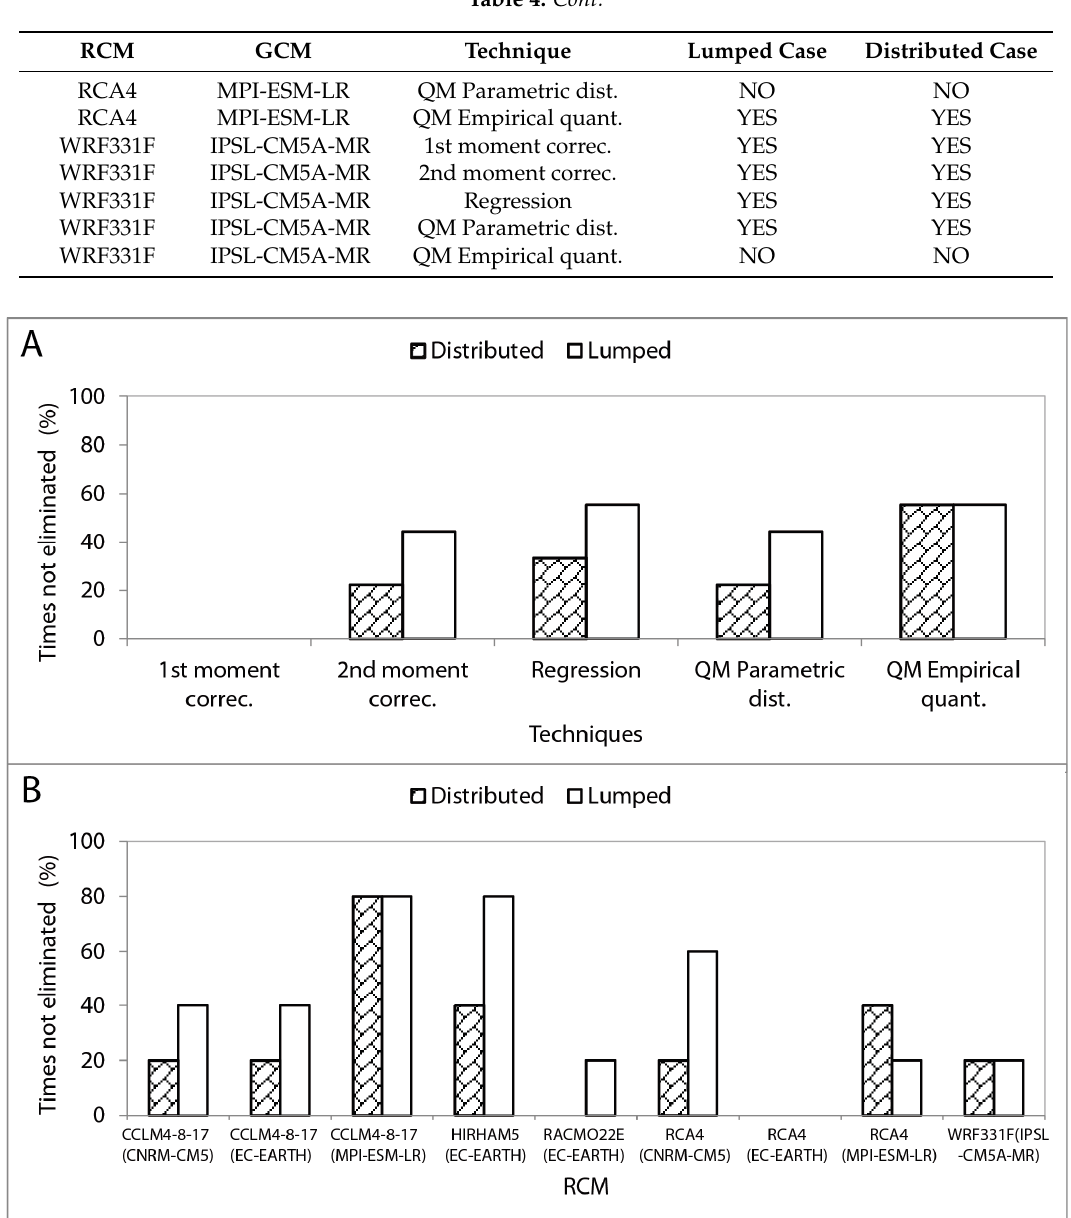
Figure 11. ( A ) Times that the techniques are not eliminated in the multi-objective analysis (bias correction approach); ( B ) Times that the RCMs are not eliminated in the multi-objective analysis (bias correction change approach).